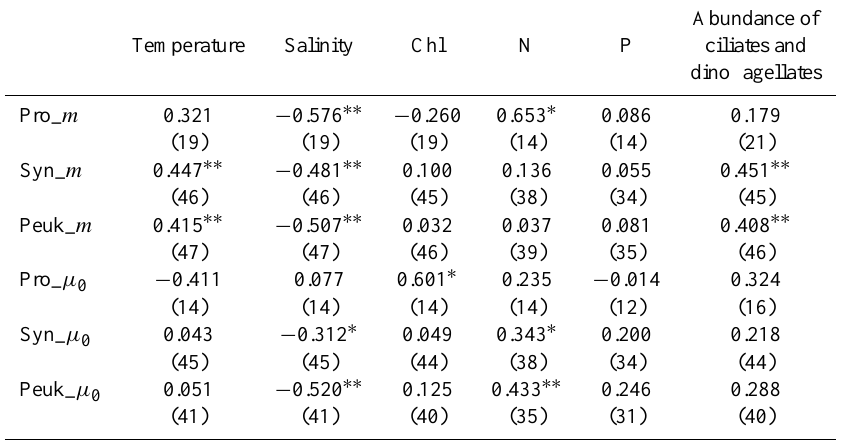
Table 5. Spearman’s rank correlation coefficient between environmental factors and m and µ of picoplankton populations. The numbers in parenthesis are N values of correlation analysis.